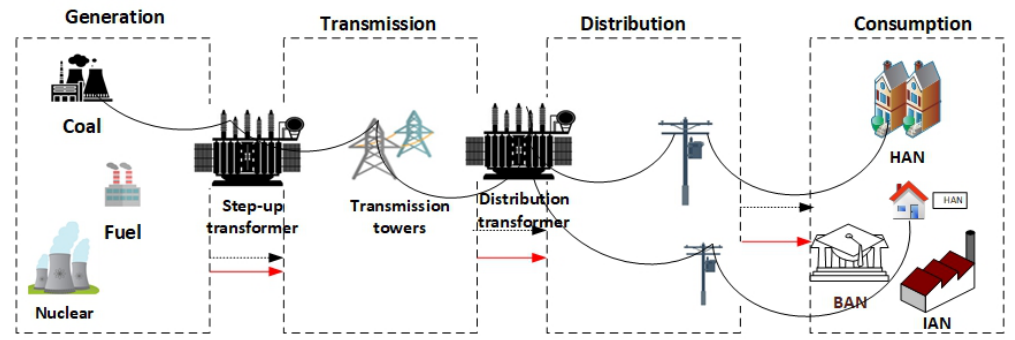
Figure 1. Conceptual model of traditional power grids. HAN, home area network; BAN, business area network; IAN, industrial area